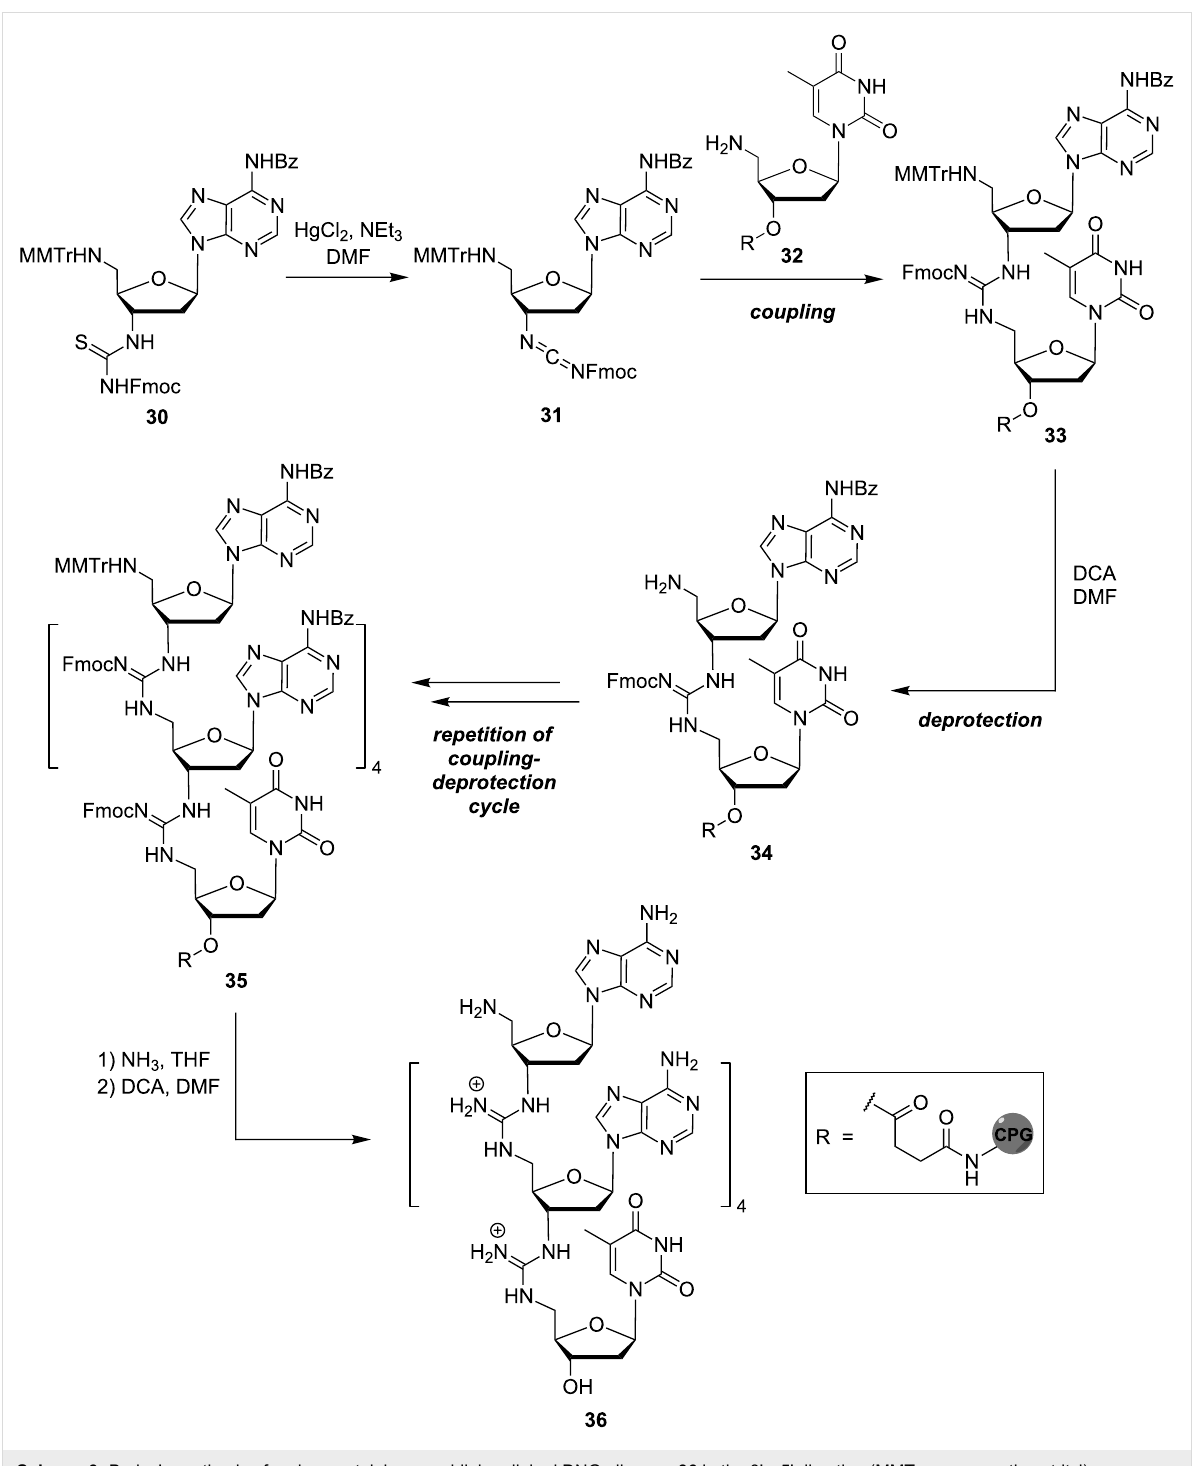
Scheme 3: Bruice's synthesis of purine-containing guanidinium-linked DNG oligomer 36 in the 3' → 5' direction (MMTr = monomethoxytrityl).